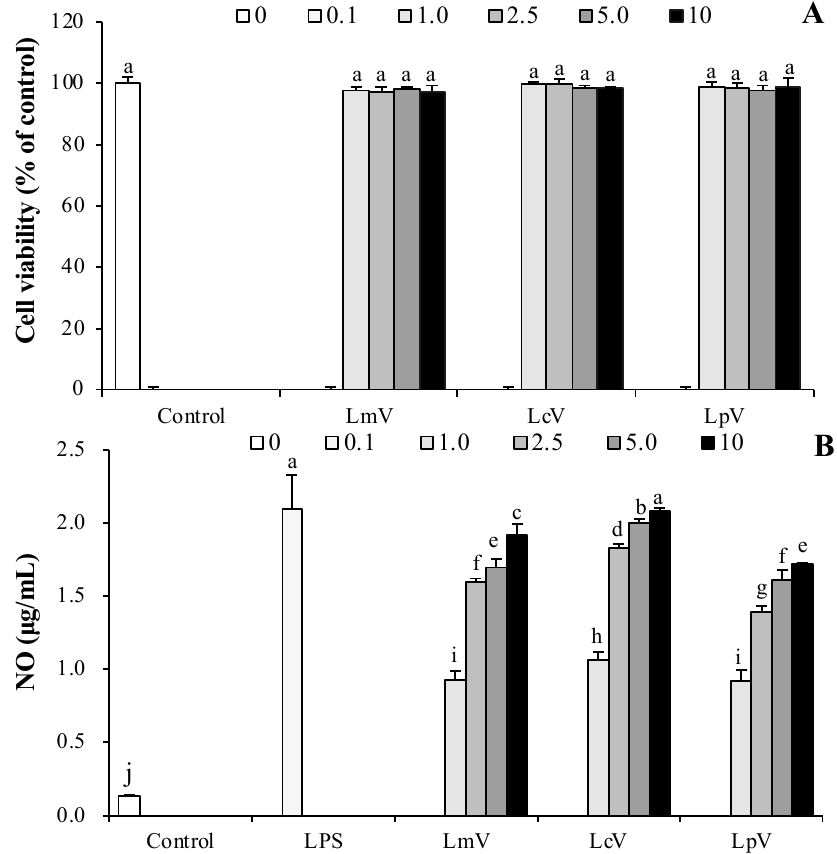
Figure 1. Effect of Le. mesenteroides, Ll. curvatus or Lp. plantarum -derived ECVs (LmV, LcV, or LpV) on ( A ) cell viability and ( B ) NO production of RAW264.7 macrophage cells. The cells were treated with concentrations (0.1, 0.1, 1.0, 2.5, 5.0 and 10 µ g/mL) of LmV, LcV, and LpV, respectively, for 24 h. Values are expressed as the mean ± SD ( n = 4) and those followed by different letters (a–j) within a property are significantly different ( p < 0.05) according to Duncan’s multiple range